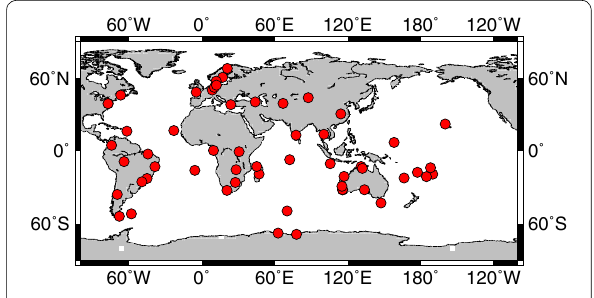
Fig. 1 Distribution of 56 stations used for POD (all stations can receive BDS-3 signals)